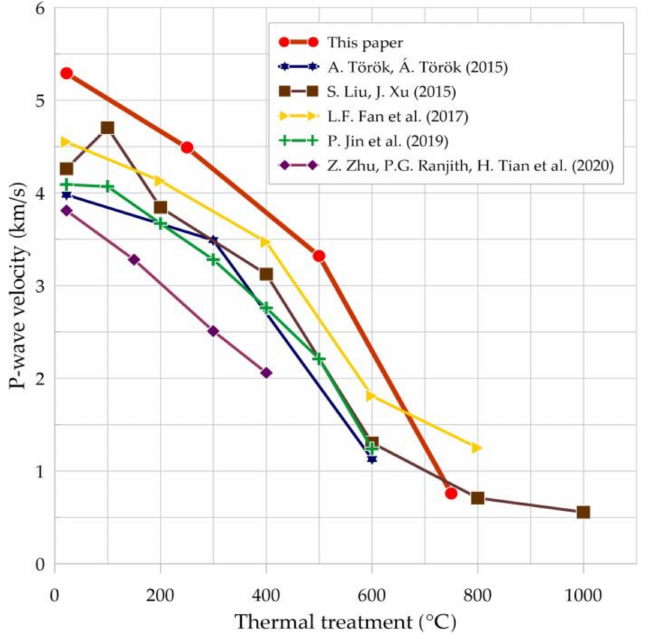
Figure 13. Comparison of P-wave velocity values of heat-treated granite samples in the literature and this paper.